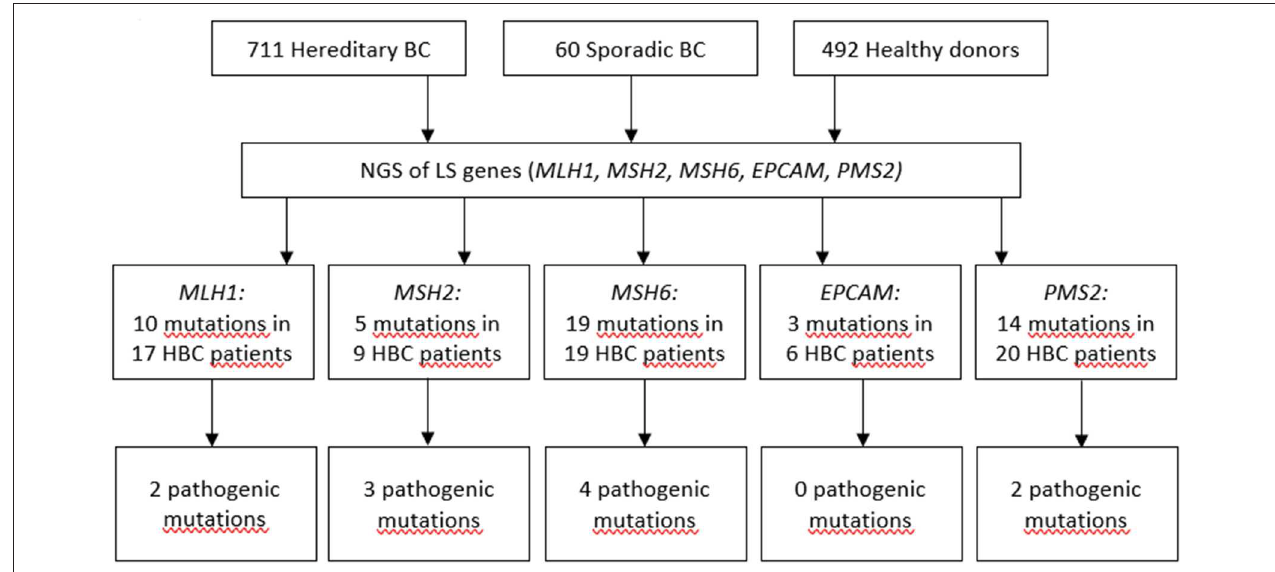
FIGURE 1 | Pathogenic mutations detected in LS